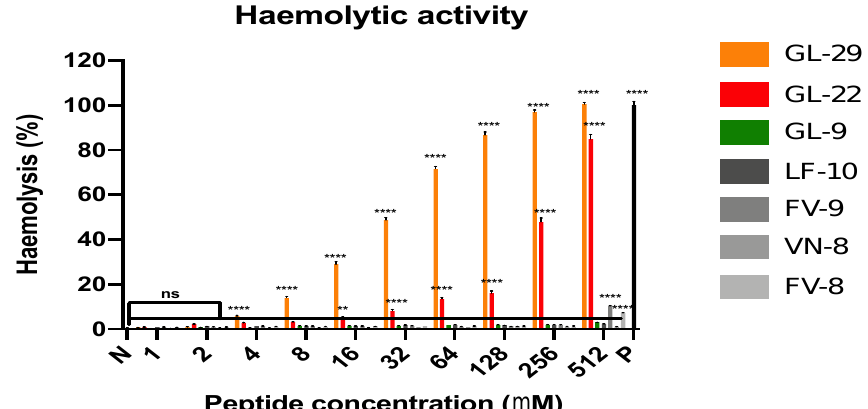
Figure 2. The haemolytic activity of GL-29 and its analogues at various concentrations from 1 to 512 µM on horse erythrocytes. P and N represent the positive control (0.1% TritonX-100) and negative control (PBS), respectively. The error bar represents means with SEM (standard error of mean) of nine repeats from three independent tests. The statistical significance was analysed using two-way ANOVA and is indicated as ns (non-significant difference), ** ( p < 0.01), **** ( p < 0.0001).